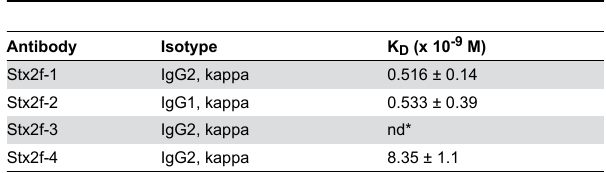
Table 2. Properties of Stx2f monoclonal